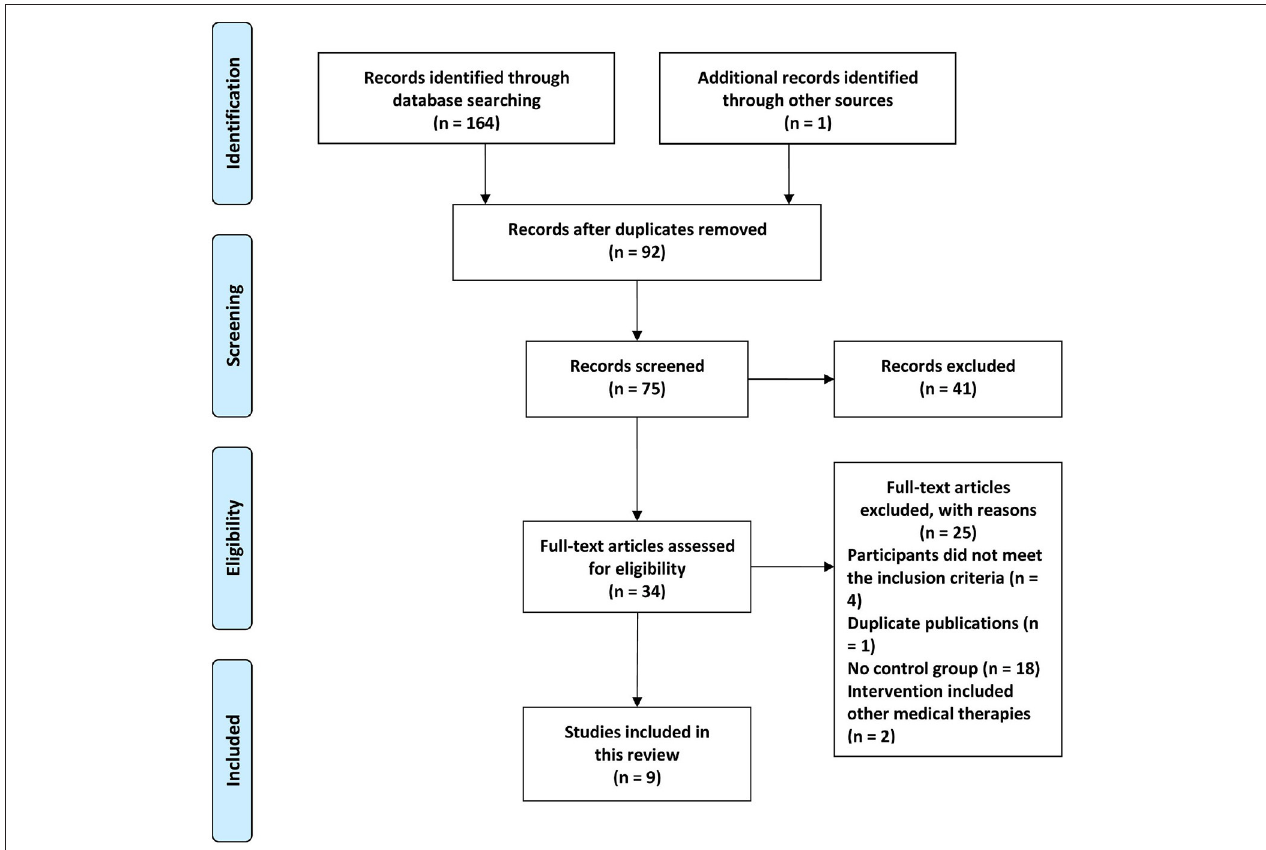
FIGURE 1 | Flow diagram of study selection and